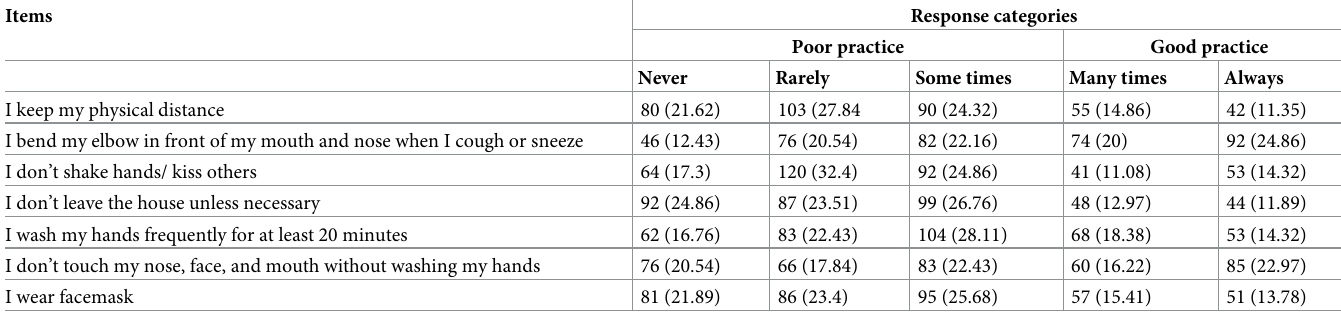
Table 2. COVID-19 preventive behaviors among secondary school students in Gondar city, Northwest Ethiopia 2020 (n = 370). Items